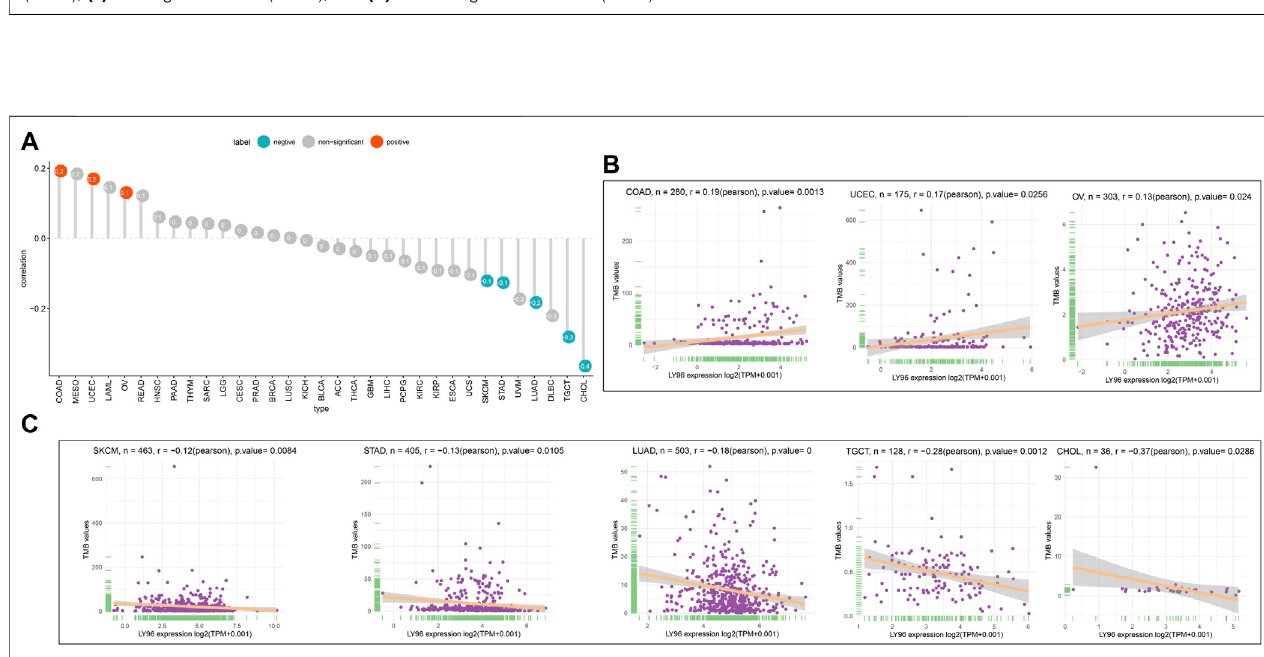
FIGURE9| CorrelationbetweenLY96expressionandTMB. (A) CorrelationbetweenLY96expressionandTMBacrosscancers. (B – C) CorrelationbetweenLY96 expression and TMB in COAD, UCEC, and OV (B) . Correlation between LY96 expression and TMB in SKCM, STAD, LUAD, TGCT, and CHOL (C) .